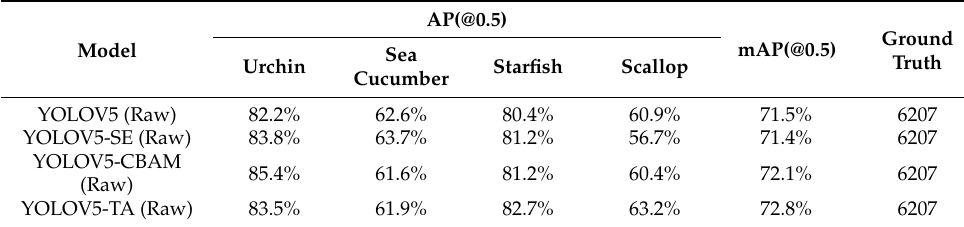
Table 2. Performance comparison of attention mechanism